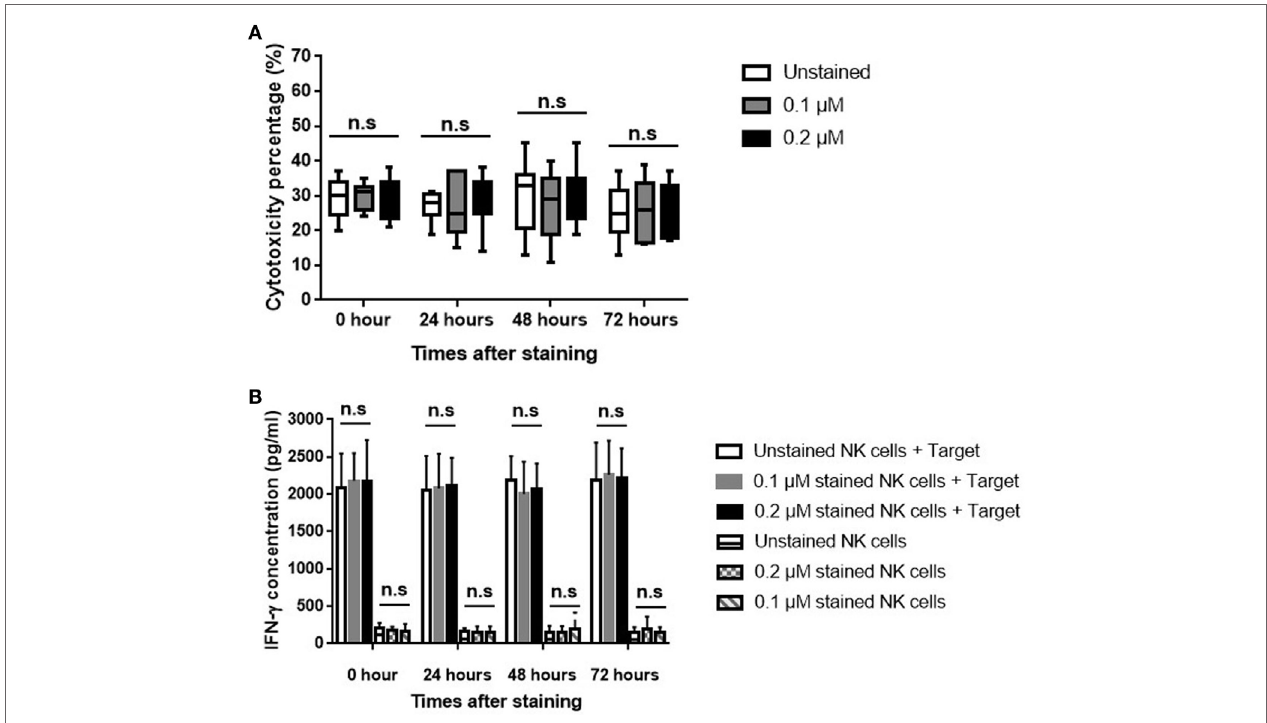
FigUre 4 | Human breast cancer MDA-MB-231 cell cytotoxicity of expanded ESNF13-stained natural killer (NK) cells. Expanded NK cells were stained with different concentrations of ESNF13 dye (0.1 and 0.2 µM) and the 4-h cytotoxicity and interferon- γ (IFN- γ ) release against human breast cancer cell line